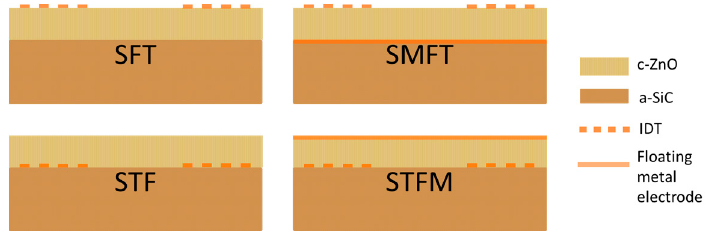
Figure 9. Cross-sectional illustrations of the four coupling configurations on a composite membrane including a piezoelectric layer (Film) onto a non-piezoelectric layer (Substrate): substrate/film/transducer (SFT), substrate/metal electrode/film/transducer (SMFT), substrate/transducer/film (STF), and substrate/transducer/film/metal electrode (STFM).